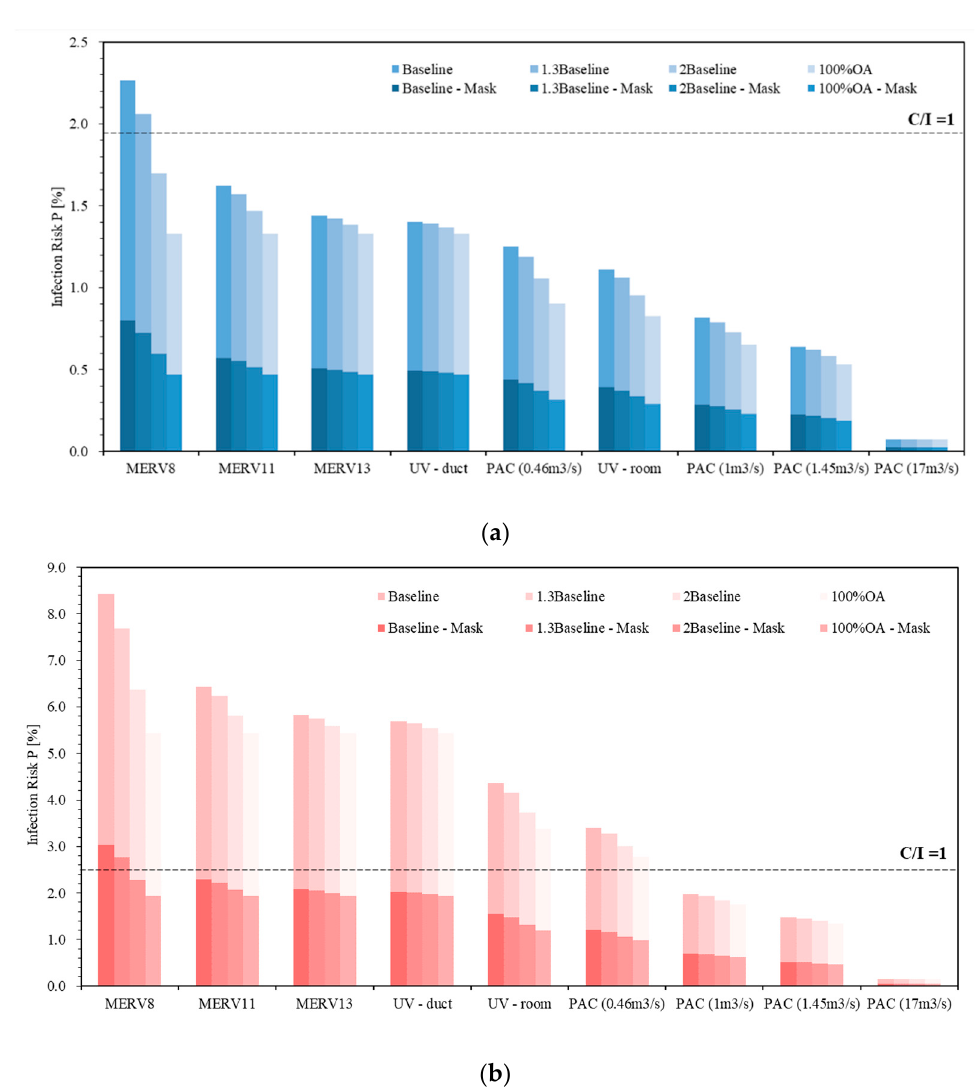
Figure 13. Individual Infection risks for Small Hotel: ( a ) Front Lounge—1 h exposure, and ( b ) Meet- ing Room—2 h exposure. C/I is the contagious potential. The spread could happen when C/I exceeds unity.